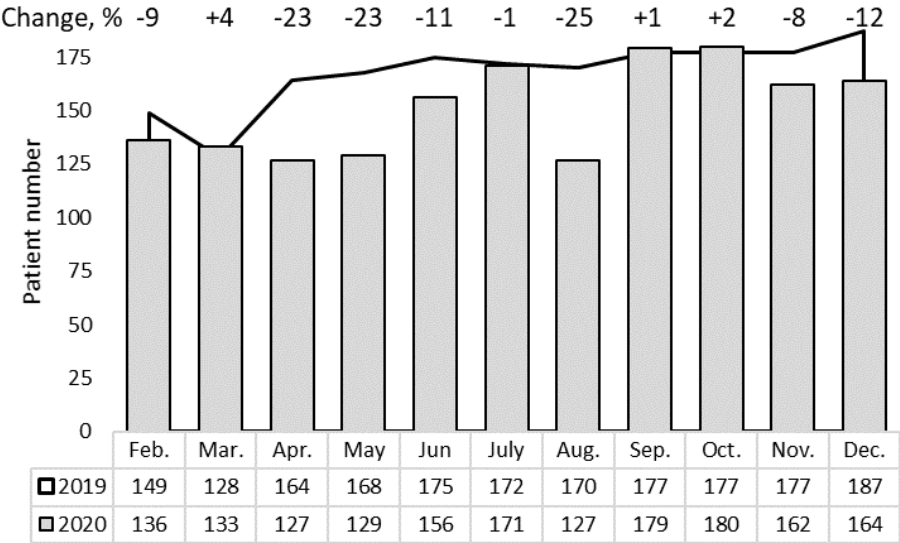
Figure 2. Number of newly diagnosed cancer patients who underwent surgical treatment.